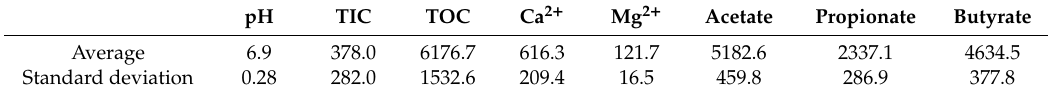
Figure 1. The schematic diagram of the simulation columns of leachate collection system (LCS). Table 1. The properties of the synthetic leachate for groups G, N, and L (mg L − 1 , except pH value).